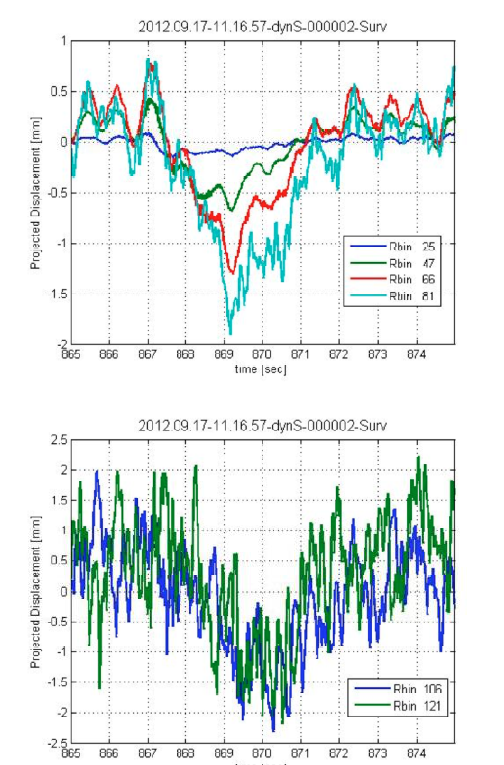
Figure 6. Vertical displacement measured during the passage of bins106 and